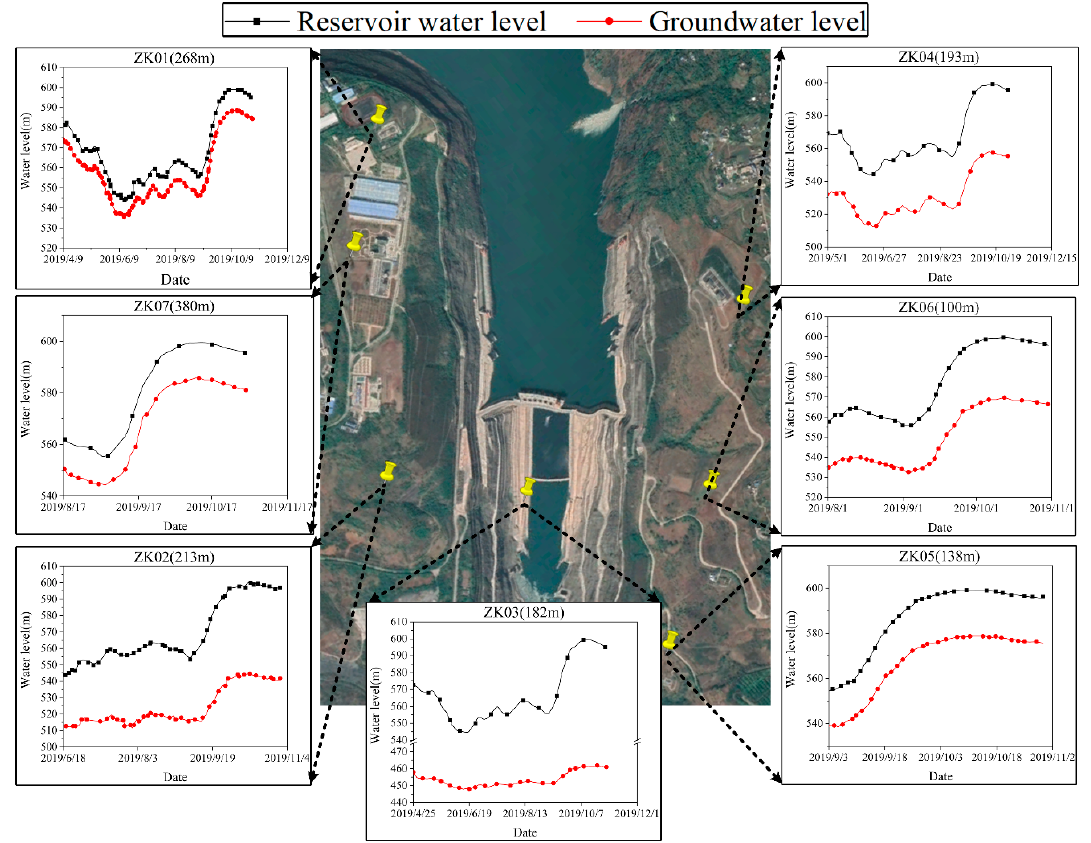
Figure 6. Location and bottom elevation of the boreholes and their seepage pressure process.